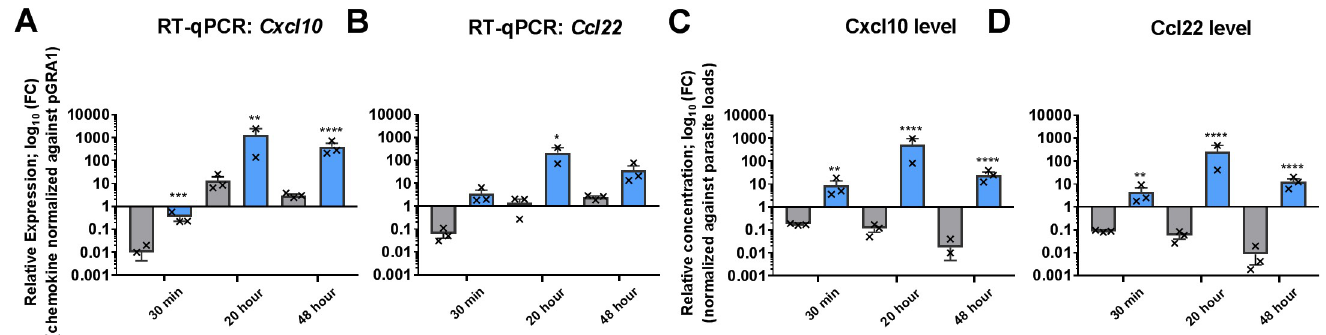
Fig 2. In vivo H . hammondi infection leads to higher levels of chemokine transcript and protein compared to T . gondii when normalized to parasite burden. Mice were infected with T . gondii (TgVEG; grey) or H . hammondi (HhAmer; blue) or mock-infected with filter-sterilized (0.2 μ m) parasite preparations. Mouse peritoneal cell RNA and their supernatants were collected at 30 min, 20 and 48 h post infection. (A-B) Bar graphs show transcript abundance (log 10 ) normalized against parasite load ( Δ C T for the host gene– Δ C T for T . gondii or H . hammondi GRA1 ). Cxcl10 transcript abundance normalized in this fashion was significantly higher in HhAmer-infected mice as compared to TgVEG infection at all time points ( � p � 0.01) and Ccl22 transcript abundance was significantly higher in H . hammondi compared to T . gondii at 20 h post-infection ( � p < 0.05). (C-D) Relative concentration of secreted cytokines normalized against parasite loads. Cxcl10 and Ccl22 levels were significantly different in response to TgVEG and HhAmer infections at all time points ( �� p < 0.01, ���� p < 0.0001). Error bars represent